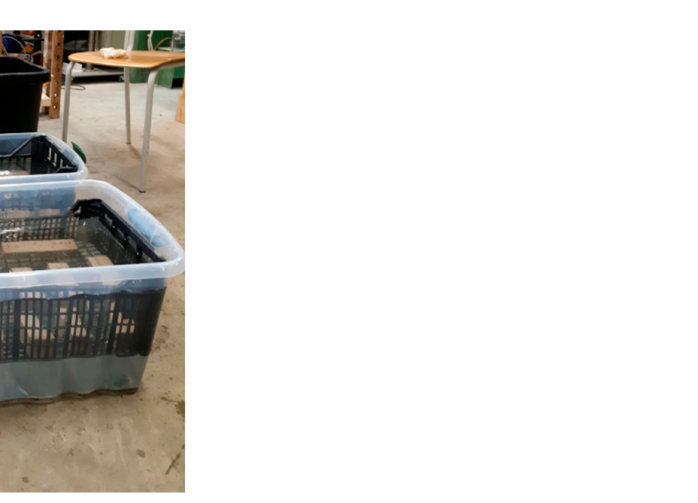
Figure 4. Specimens immersed in exposure environments: the saltwater environment in the black tank, moisture environments in white tanks.